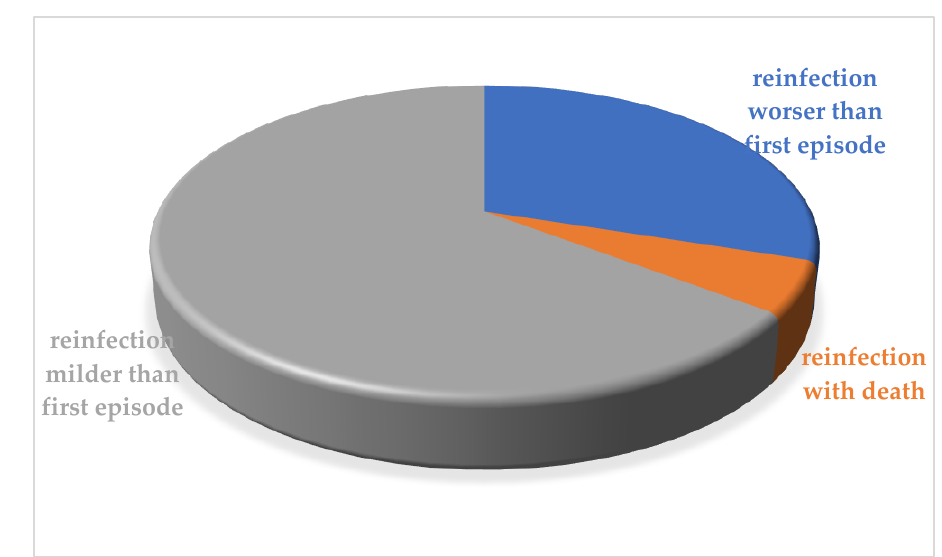
Figure 6. The evolution of the reinfection episode was more severe in 35.3% of cases.